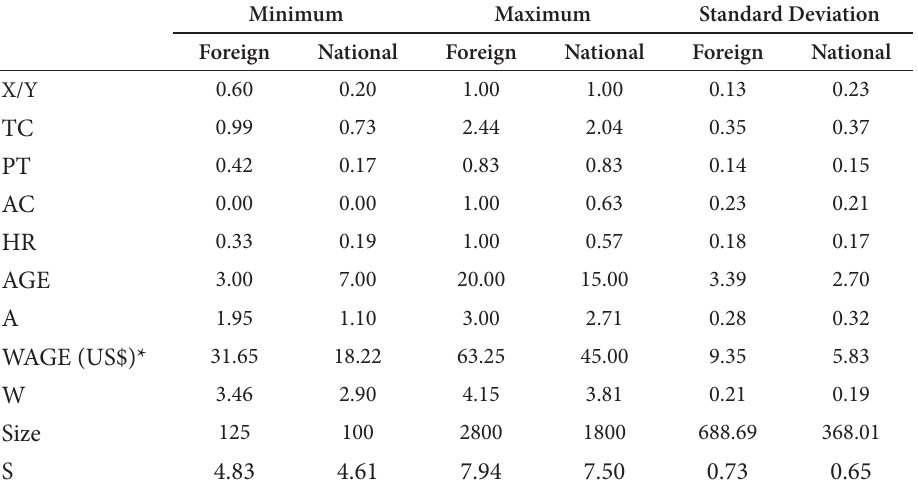
Table 3. Descriptive statistics, Garment firms, Myanmar,